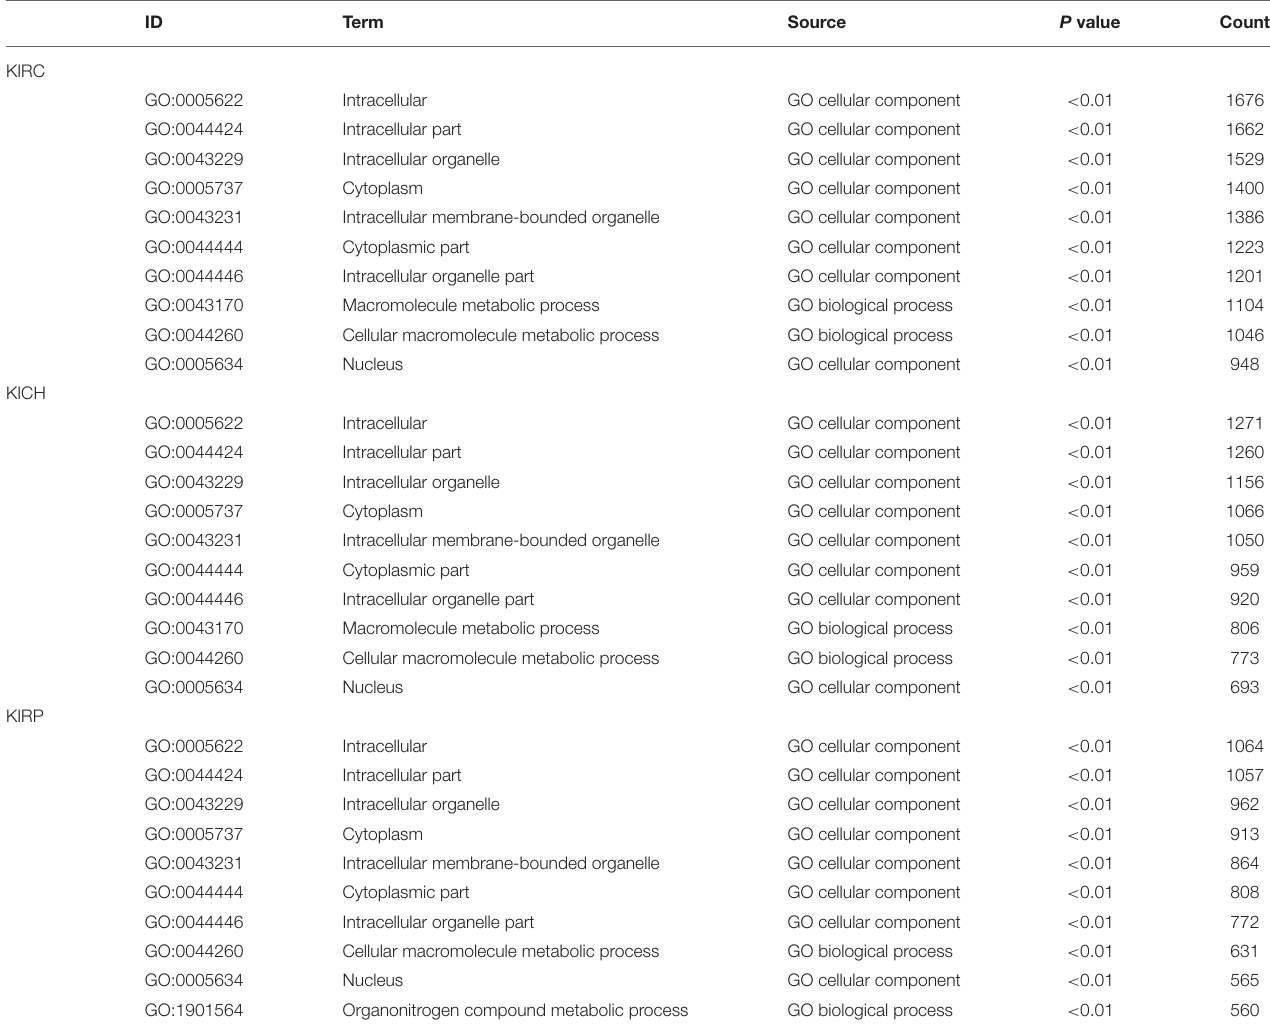
TABLE 4 | The information of GO terms with the most